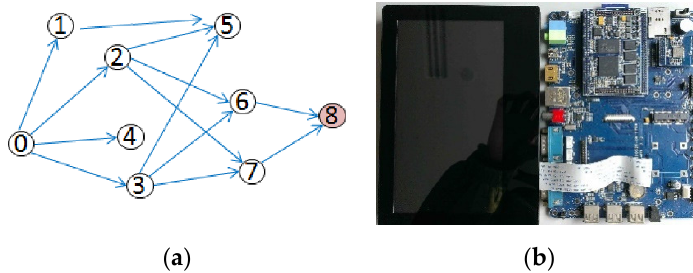
Figure 8. Distribution of nodes and the single node platform. ( a ) Distribution of nodes in the field test and ( b ) embedded Linux platforms as nodes in the test.